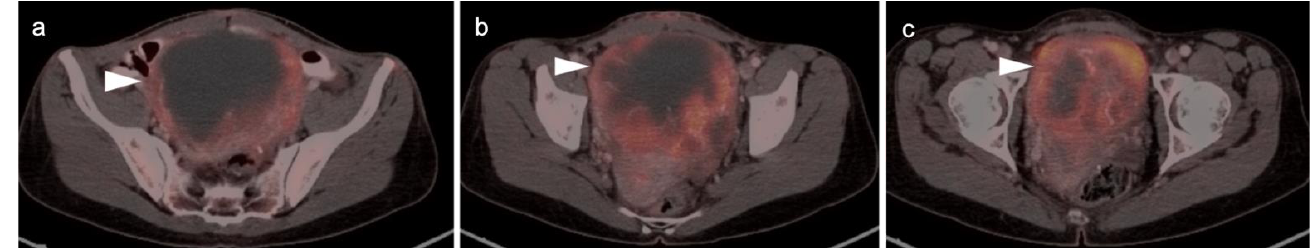
Figure 10. Gastric carcinoma with a Krukenberg tumor of the ovary shown on axial FDG PET-CT images of the abdomen and pelvis. ( a ) Axial FDG PET-CT images of the upper abdomen show the stomach to be only mildly metabolically active in this patient with a signet-ring adenocarcinoma of the stomach (white arrow). It would be difficult to distinguish this tumor on PET-CT from normal gastric activity. ( b ) Axial FDG PET-CT of the pelvis reveals a mildly metabolically active right ovarian mass (white arrowhead) which was a Krukenberg tumor (metastatic from gastric cancer). Krukenberg tumors account for 1 – 2% of ovarian tumors.